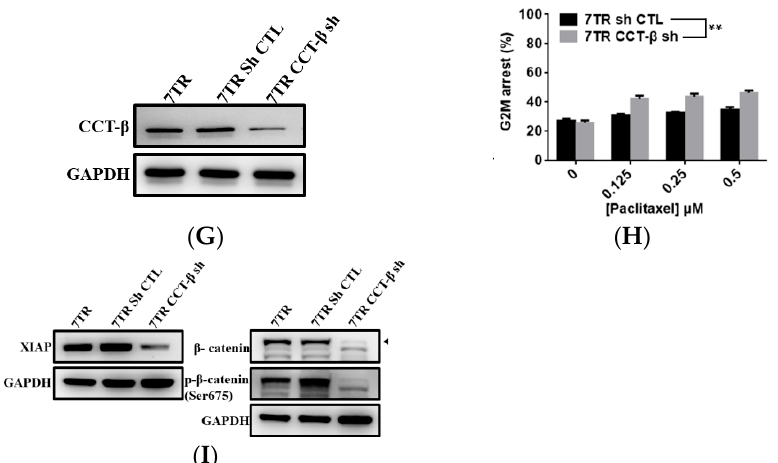
Figure 4. Levels of CCT- β were associated with chemoresistance in MCF-7 and 7TR cells. ( A ) Western blot analysis of the CCT- β expression levels in MCF-7 and 7TR cells. ( B ) The apoptotic levels of MCF-7 and 7TR cells after the paclitaxel treatment assessed by flow cytometry analysis. ( C ) Western blot analysis of the XIAP, β -catenin, and S675-phosphorylated β -catenin expression levels in MCF-7 and 7TR cells. ( D ) Overexpression of CCT- β in MCF-7 cells. ( E ) The apoptotic levels of the MCF-7 cells with and without CCT- β overexpression after the paclitaxel treatment assessed by flow cytometry analysis. ( F ) Higher expression levels of XIAP, β -catenin, and S675-phosphorylated β -catenin caused by CCT- β overexpression in MCF-7 cells. ( G ) Lower expression levels of CCT- β in the siRNA-treated 7TR cells. ( H ) The apoptotic levels of the 7TR cells with and without CCT- β knockdown after the paclitaxel treatment assessed by flow cytometry analysis. ( I ) The lower expression levels of XIAP, β -catenin, and S675-phosphorylated β -catenin caused by CCT- β knockdown in 7TR cells. Data are presented as the mean ± S.D. of three independent experiments. ** p < 0.01 vs. the control.